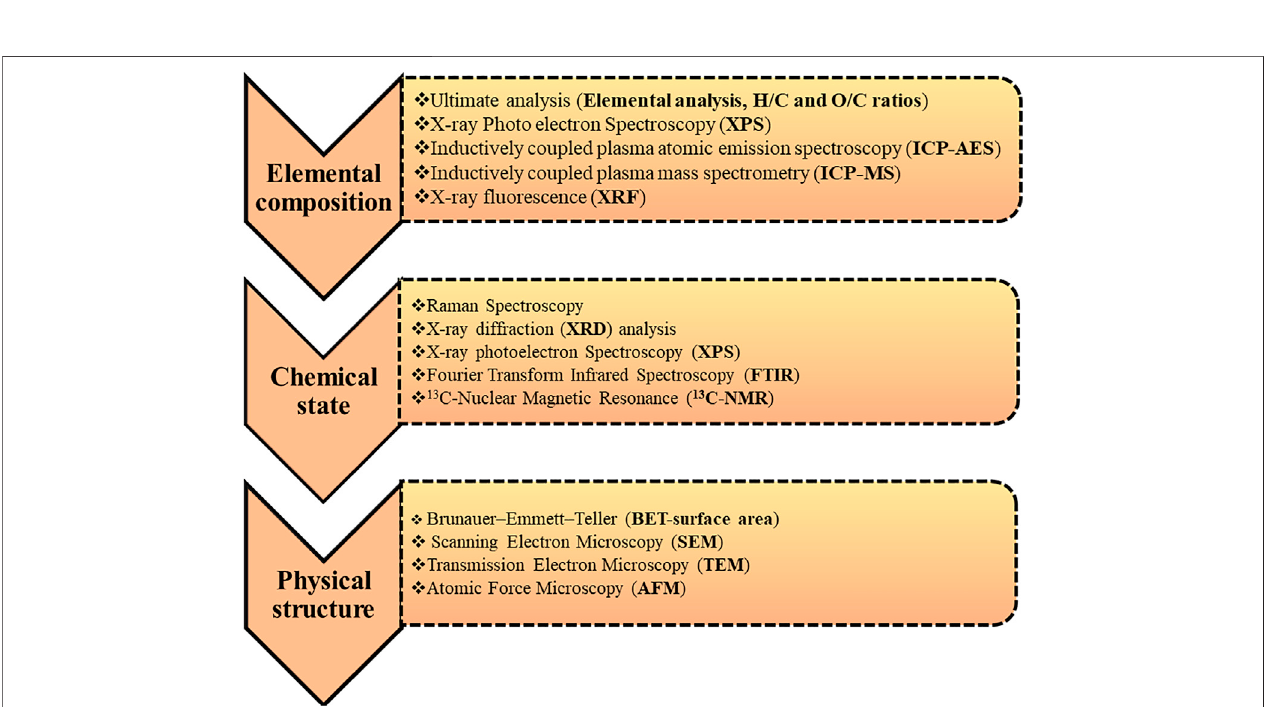
FIGURE 8 | Analytical techniques to determine the change in physicochemical properties of biochar.